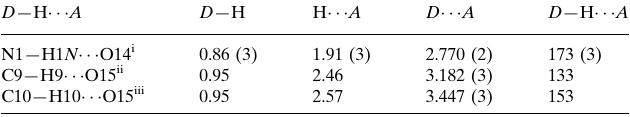
Hydrogen-bond geometry (A˚ , (cid:1)